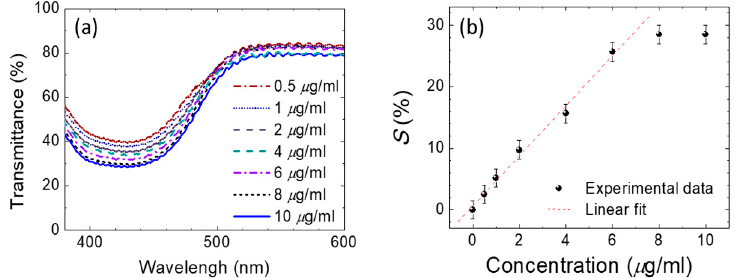
Figure 6. ( a ) The relationships of the light intensities from image integration software of a DDLC-bioinspired sensor exposed to several BSA concentrations. ( b ) The calibration standard of different major brand smart-phones.